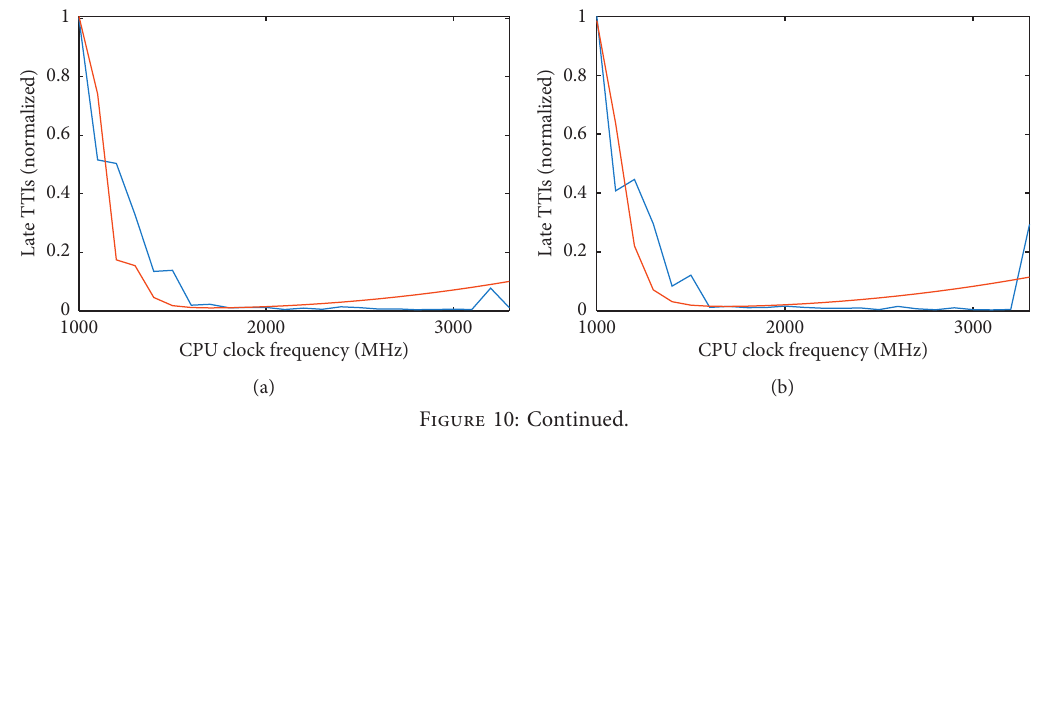
Figure 9: System 1: comparison of actual and predicted lates for f (d) 20MHz